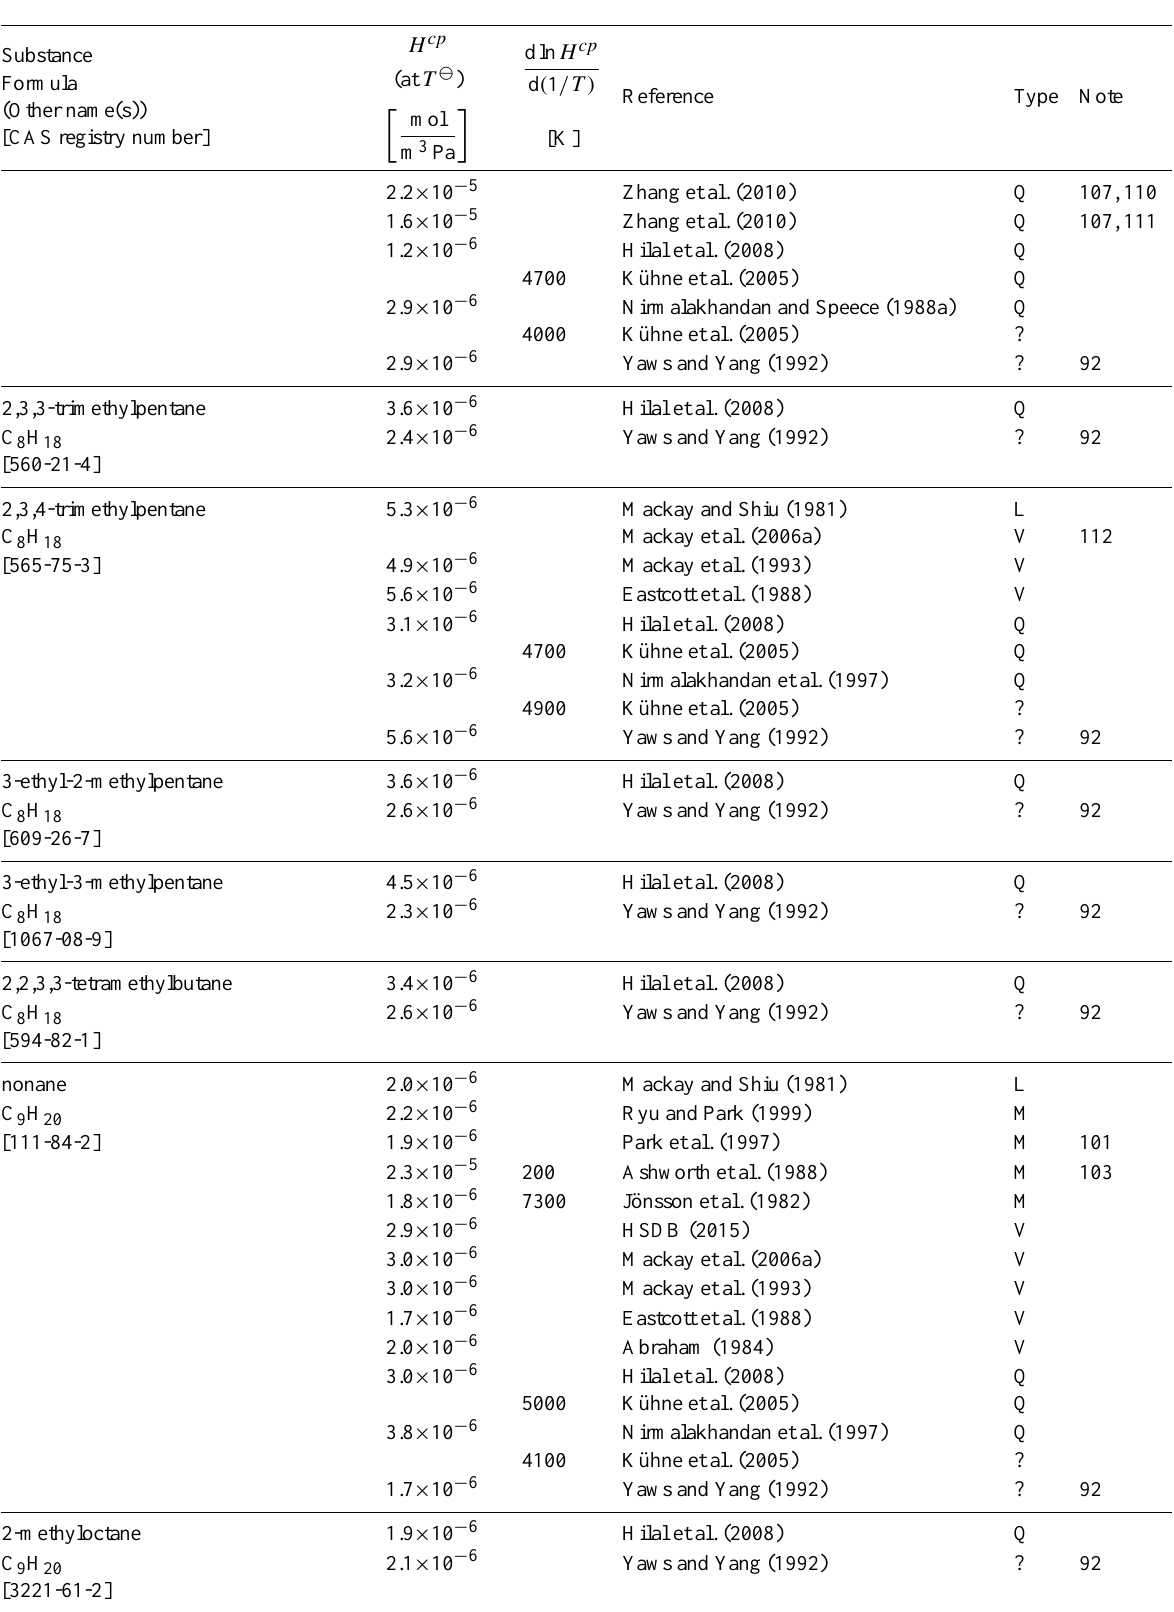
Table 6: Henry’s law constants for water as solvent